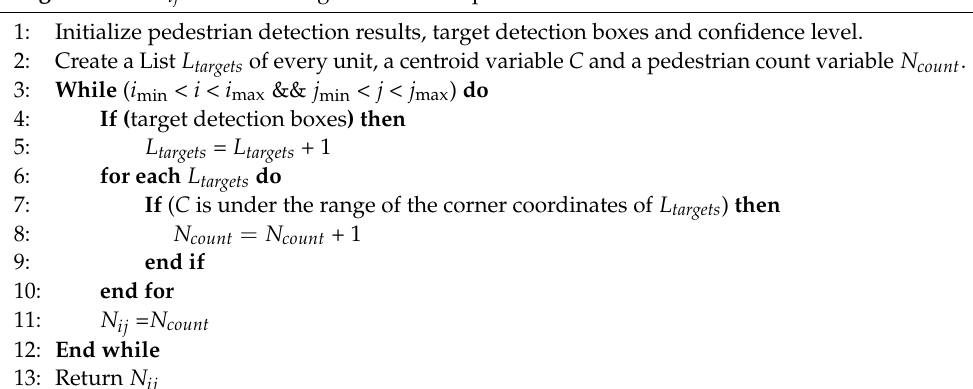
Algorithm 1: N ij calculation algorithm in 3D